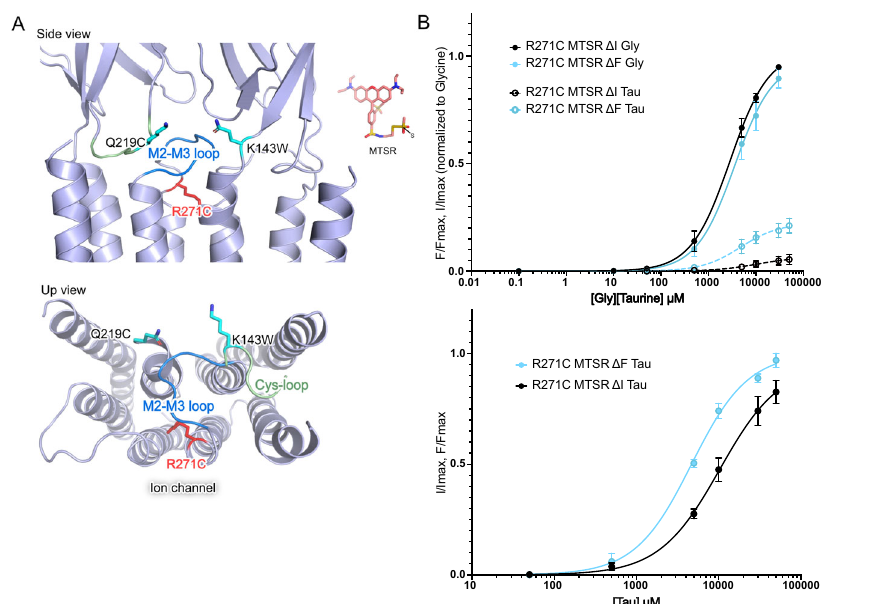
Fig. 6 | Characterization of R271C by VCF on C41V GlyR. A Localization of the R271C mutation on the GlyR compared to the sensor K143W/Q219C (PDB:6PXD). B Upper panel: Δ I (cyan) and Δ F (black) dose-response curves (normalized to the glycine maximal response recorded on each individual oocyte) with mean and